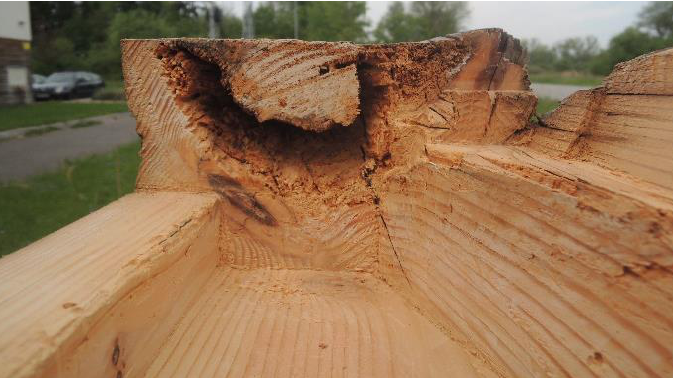
Figure 24. A scheme of the extent of the rot, beam (I2) (yellow — replacement, grey — standard wood density without the need of repair). Arrow and + marking points measured with Resistograph.